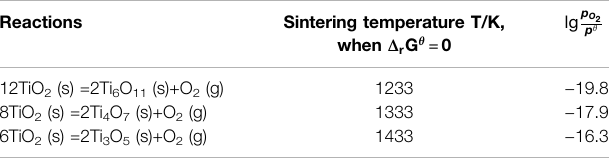
TABLE 2 | Equilibrium oxygen partial pressure of reactions in the Ti – O system at a speci fi ed temperature.